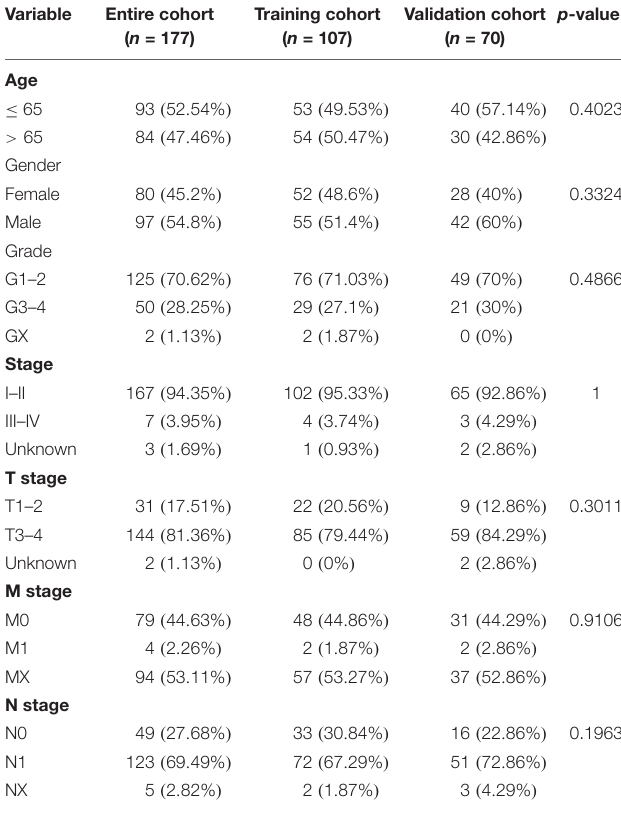
TABLE 1 | Clinical information of pancreatic cancer patients in the training, validation, and entire cohort.